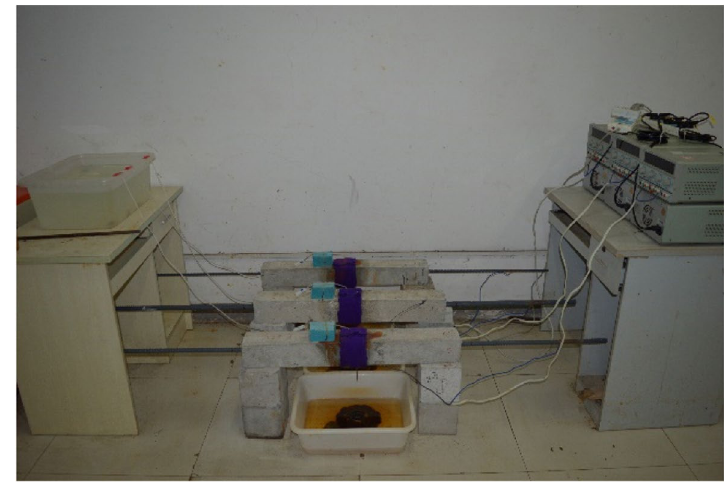
Fig. 3 Corrosion process diagram of reinforced concrete structure